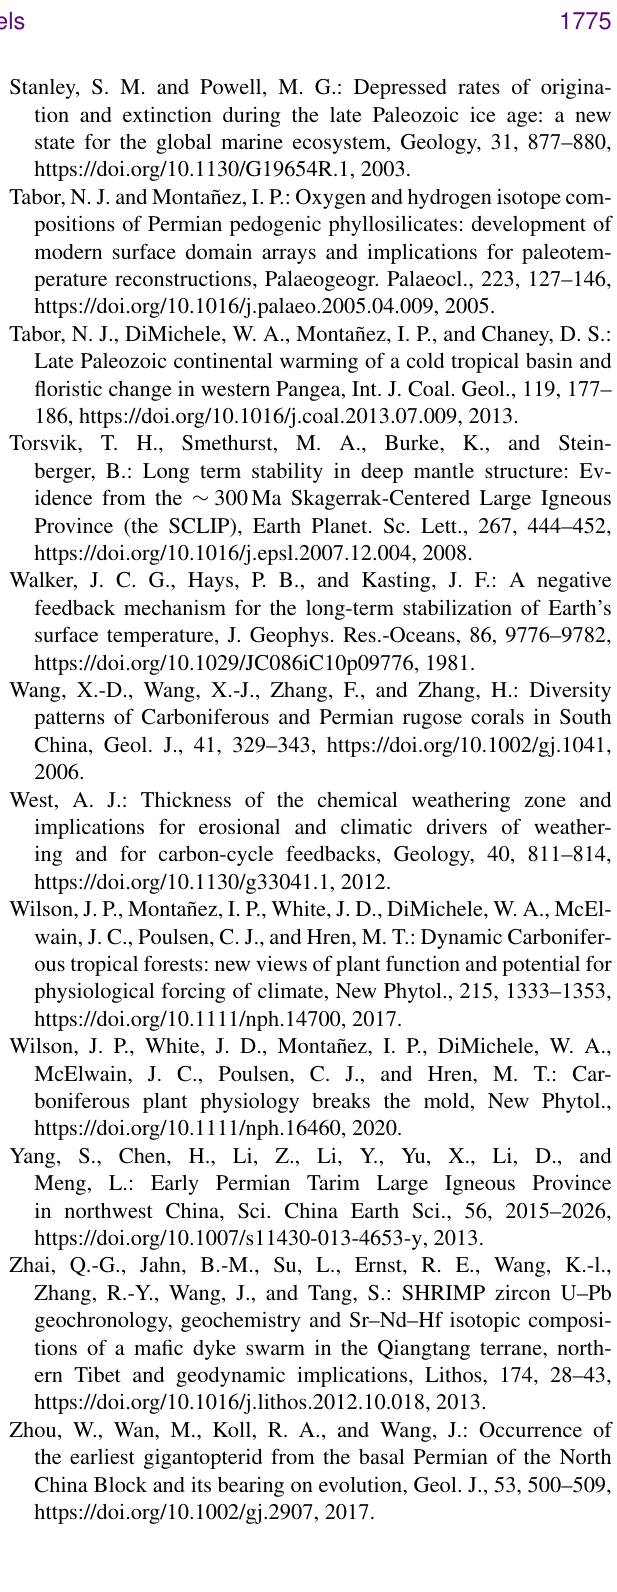
Tabor, N. J. and Montañez, I. P.: Oxygen and hydrogen isotope